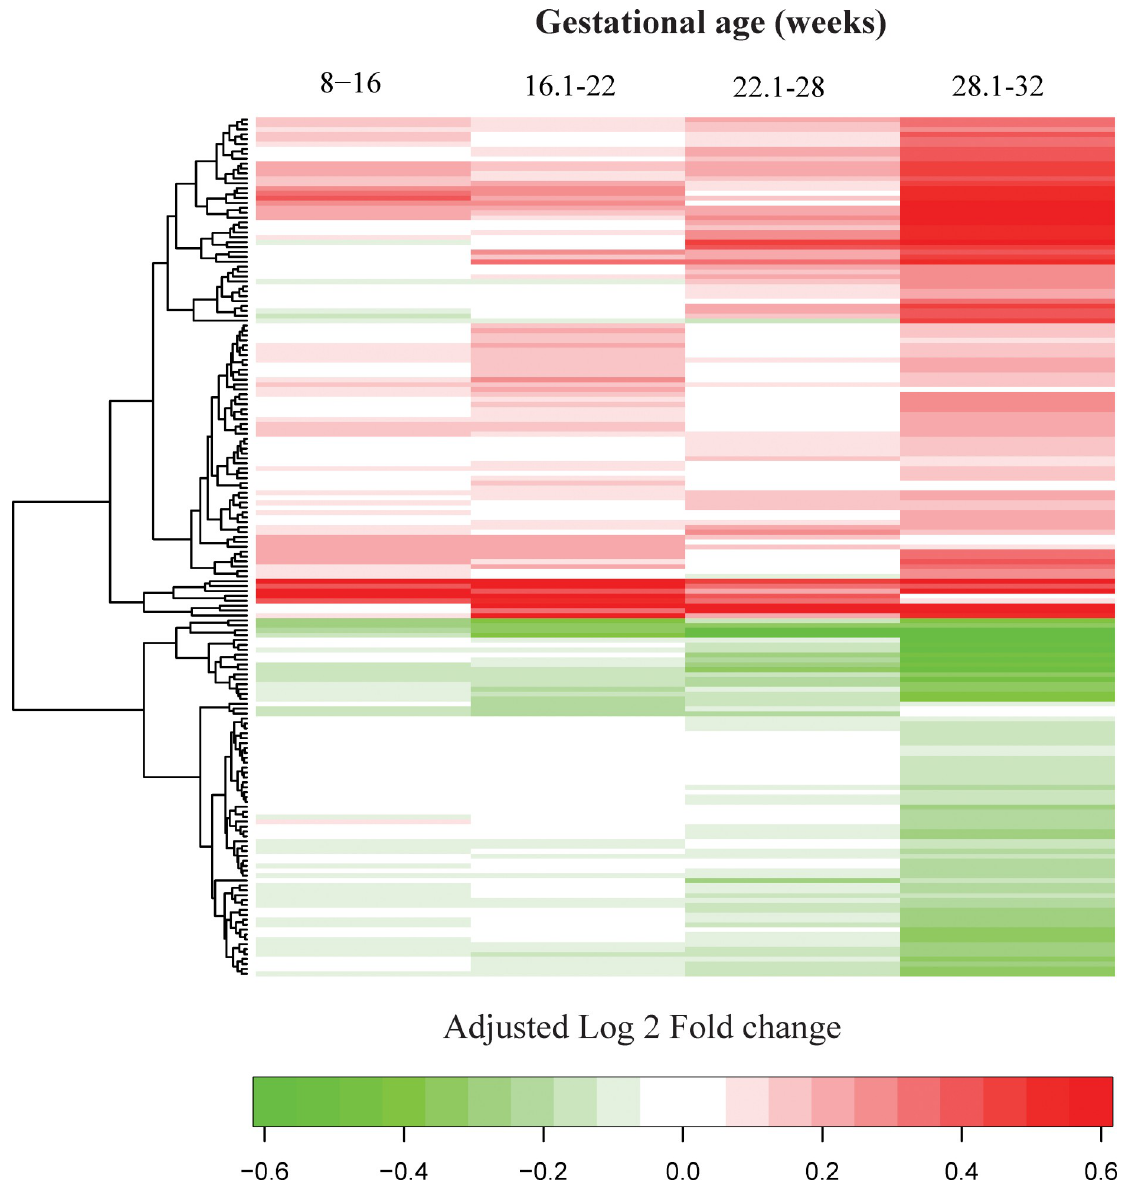
Fig 7. A summary of differential protein abundance between early preeclampsia and normal pregnancy throughout gestation. The values shown using a color scheme represent the log 2 fold change in MoM values between the cases and controls (green = lower, red = higher mean MoM in cases versus controls). Fold changes > 1.5 (absolute log 2 fold change > 0.58) were reset to 1.5 to enhance visualization of the data.